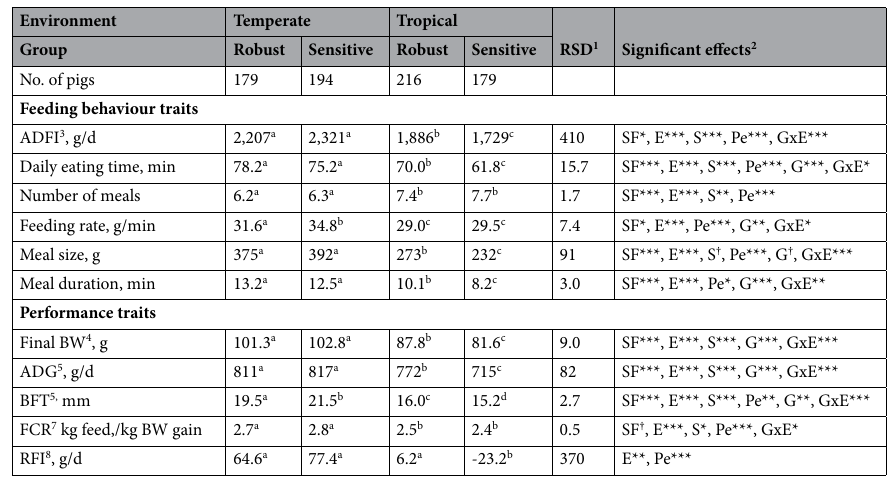
Table 2. Least squares means effect of robust and sensitive groups, production environments sire family and sex on feeding behaviour and performance traits. a-d Within a row, means with a different superscript letter differ, P < 0.05. 1 Residual Standard Deviation. 2 From an analysis of variance with a linear model including the effects of Sire Family (SF) within Group, Environment (E), Sex (S), Period of feed intake recording (Pe), Group (G) and their interactions as fixed effect. Batch within environment was significant for all traits and is not reported in the table. Statistical significance: ***P < 0.001, **P < 0.01, *P < 0.05, † P ≤ 0.10. 3 ADFI = Average Daily Feed Intake. 4 BW = Body Weight. 5 ADG = Average Daily Gain between 11 and 23 weeks of age. 6 BFT = Backfat Thickness at 23 week of age. 7 FCR = Feed Conversion Ratio between 11 and 23 weeks of age. 8 RFI = Residual Feed Intake between 11 and 23 weeks of